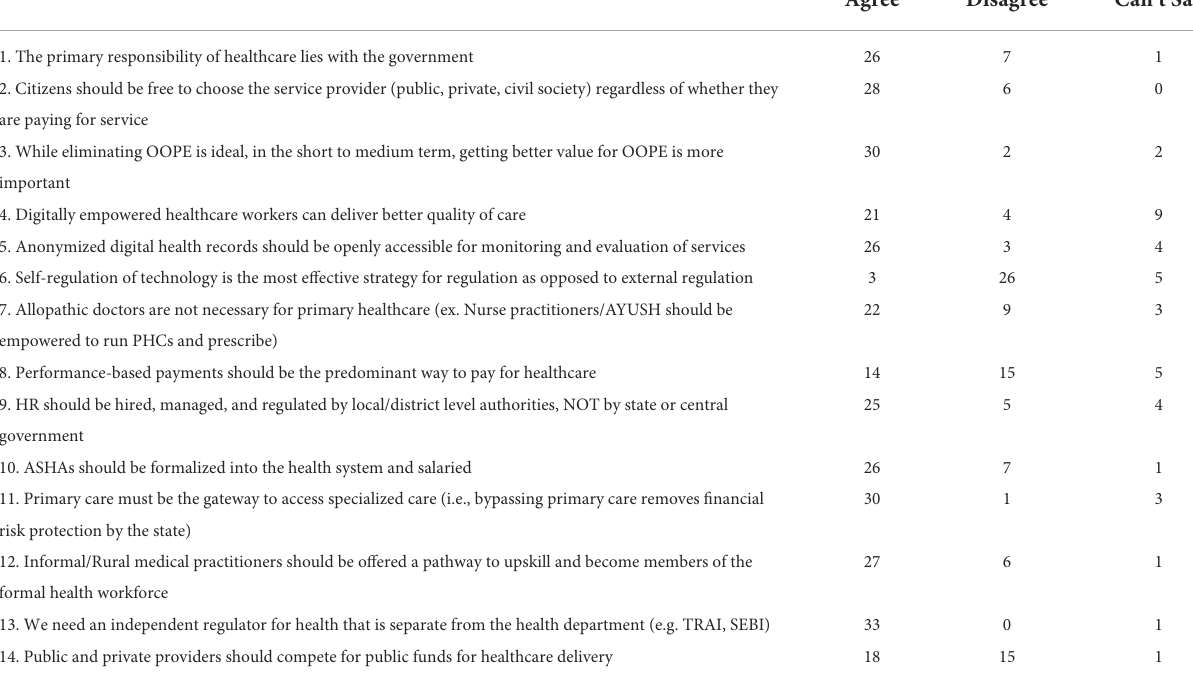
TABLE 2 Anonymous poll results on contended issues from the 2nd cross-workstream workshop.